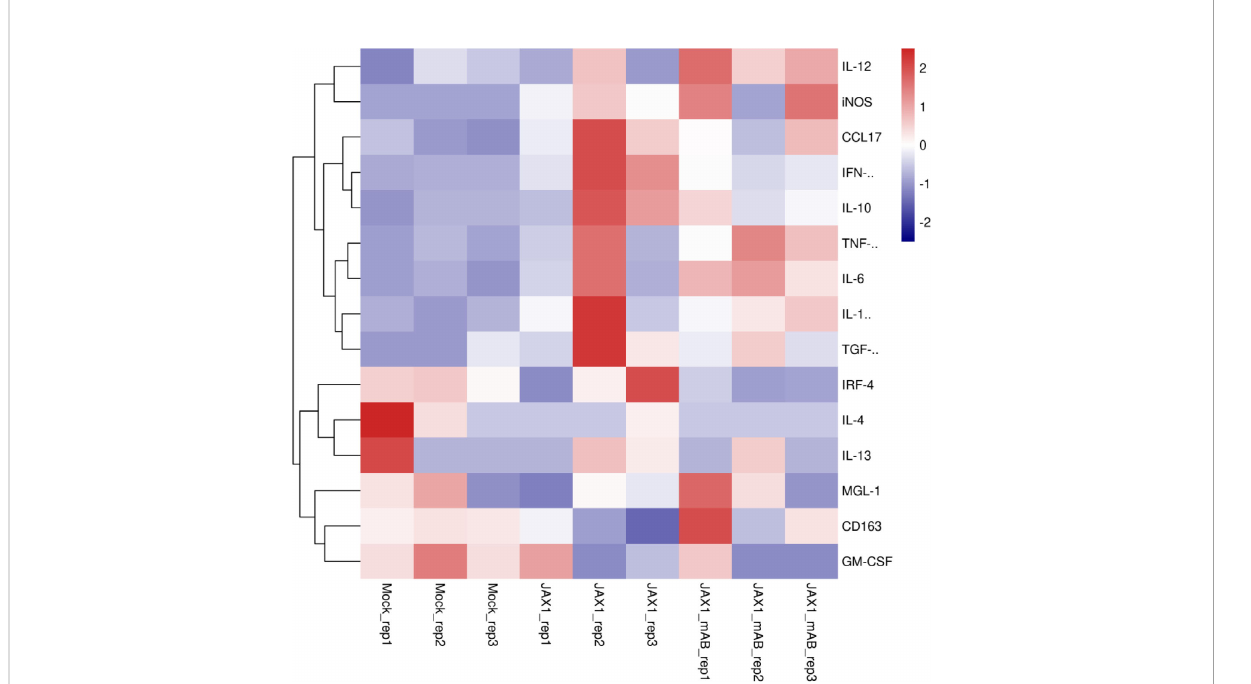
FIGURE 7 Transcriptome pro fi ling of pGM-CSF activated genes in PAMs isolated from PRRSV-JXA1-infected piglets with or without therapeutic mAb treatment. Heatmap analysis of genes downstream of pGM-CSF from PAMs collected from PRRSV-JXA1 infected piglets (JXA1) and PAMs from PRRSV-JXA1 infected but treated with therapeutic mAb (JXA1_mAb). The health piglets inoculated with PBS was included as control